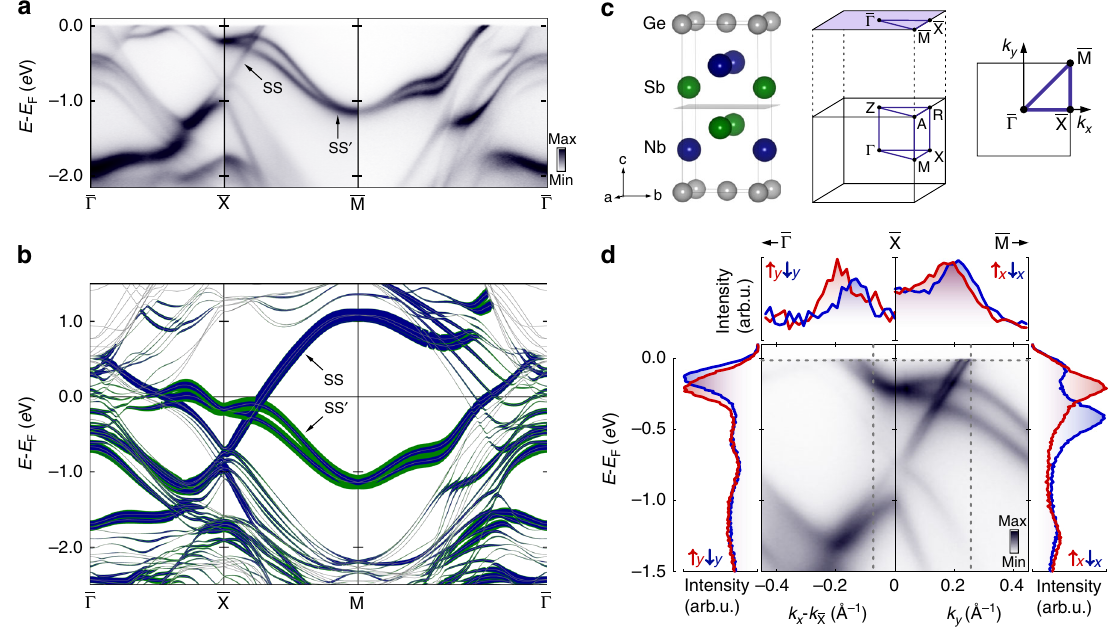
Fig. 1 Spin-polarised surface electronic structure of NbGeSb. a ARPES dispersions along the high-symmetry lines of the surface-projected Brillouin zone of NbGeSb. b Corresponding DFT slab calculation, with line colour and weight representing the wavefunction projection onto the surface Nb (blue) and Sb (green) atoms. c Crystal structure of NbGeSb with its primary cleavage plane shown; the bulk and surface projected Brillouin zones are also shown. d ARPES measurements in the vicinity of the X point. A clear splitting of each set of surface states is visible and spin-resolved energy (EDC) and momentum (MDC) distribution curves (shown left/right and top) show this to be a spin splitting. The spin quantisation axis is normal to the high- symmetry line along which the measurement is